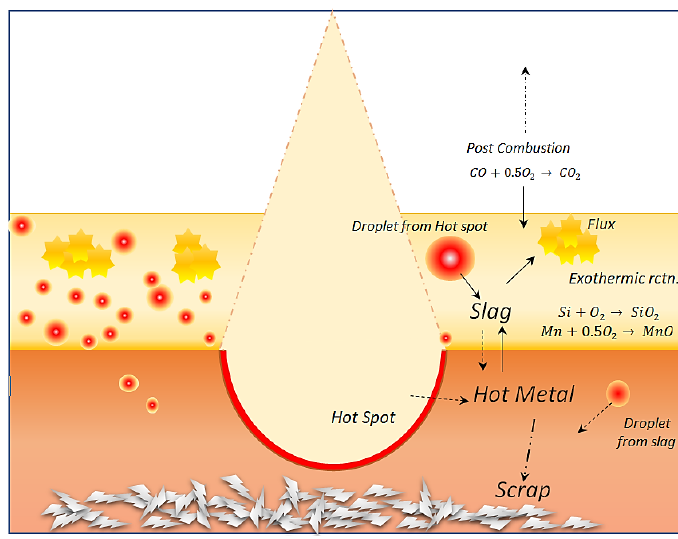
Figure 5. Heat transfer between different zones in a BOF